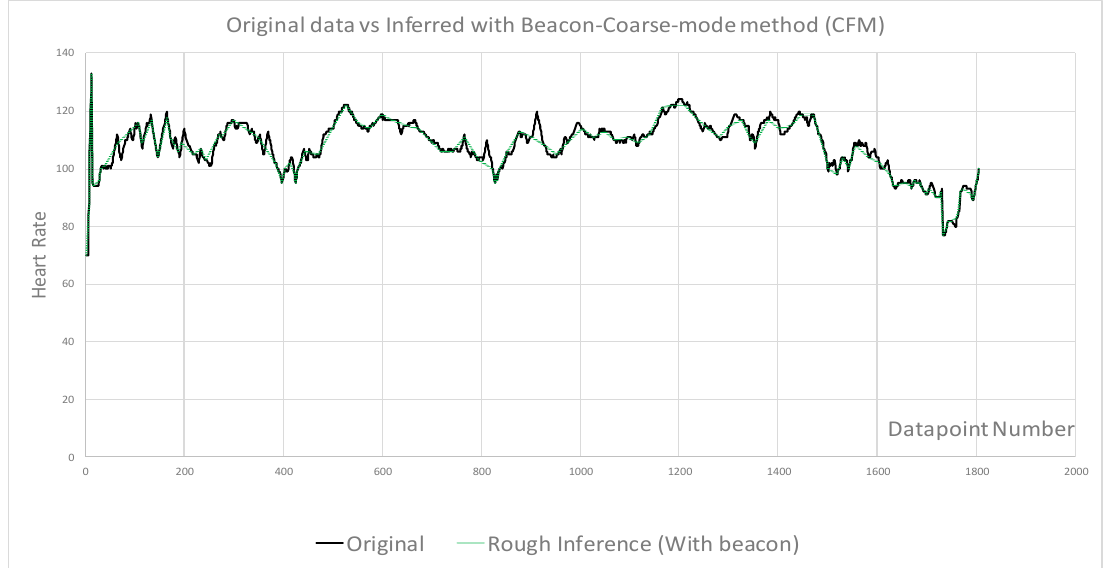
Figure 8. Original data points versus Beacon-Coarse-mode method (BCM) applied for inference (original DP: 1800, inferred DP: 202). Beacons improve accuracy significantly, as compared to without beacons.